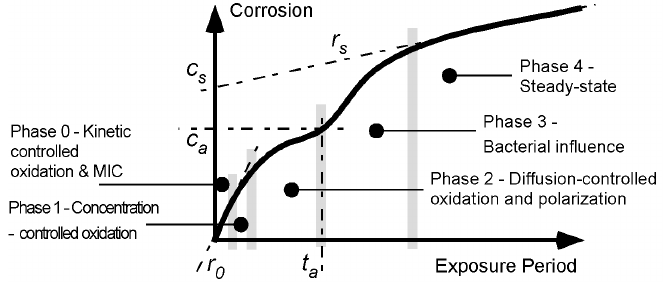
Figure 1. Bi-modal model for development of corrosion loss as a function of increased exposure time [2]. The first mode is from time 0 to t a and this is followed by the second mode. The parameters ( r 0 , t a , c a , c s and r s ) used to describe the model are